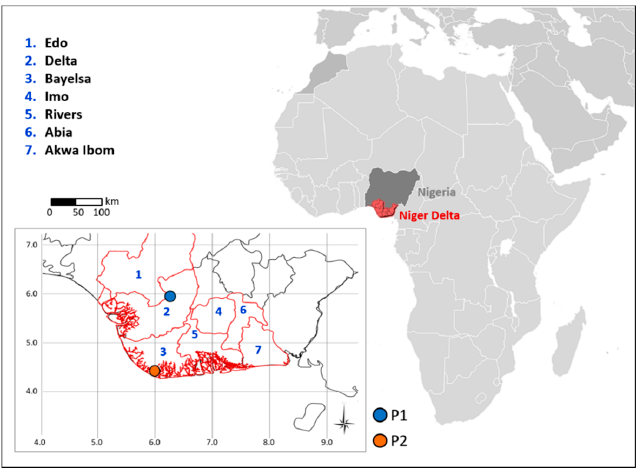
Figure 1. The Niger Delta region (red borders). Within the map, the seven states analyzed in this work are numbered and named. P1 and P2 are two locations used in the analyses (see text).